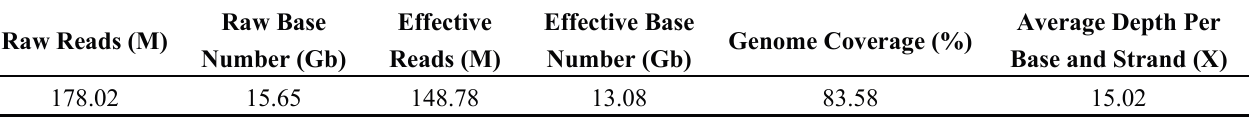
Table 1. Summary of sequencing results and reads